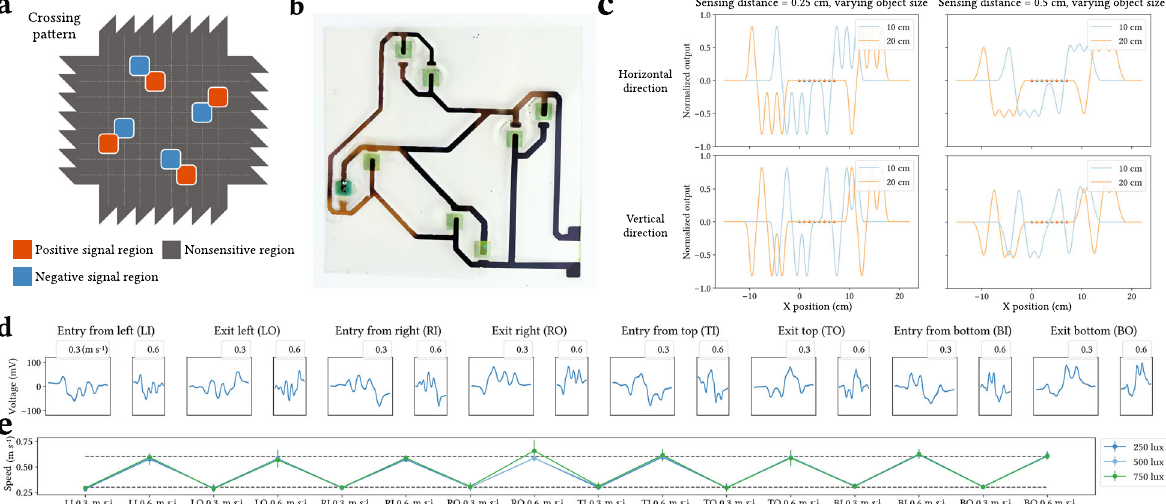
Fig. 4 Crossing pattern. a Design of a computational photodetector with a crossing pattern. b A prototype with an interspace of 1 cm and overall size of 8 × 8 cm. c Simulation of the computational photodetector responding to an object of 10 and 20 cm width moving in the horizontal and vertical direction at a height of 0.25 and 0.5 mm. d Sensor output from all the motion events with varying object speed, under 250 lux illumination. Under 500 and 750 lux illumination, the signal has a similar envelope with slightly larger magnitudes. The object size is fi xed at 16 cm and the sensing range is 0.25 cm for all conditions. e Speed detection result for the various conditions of ambient light and object